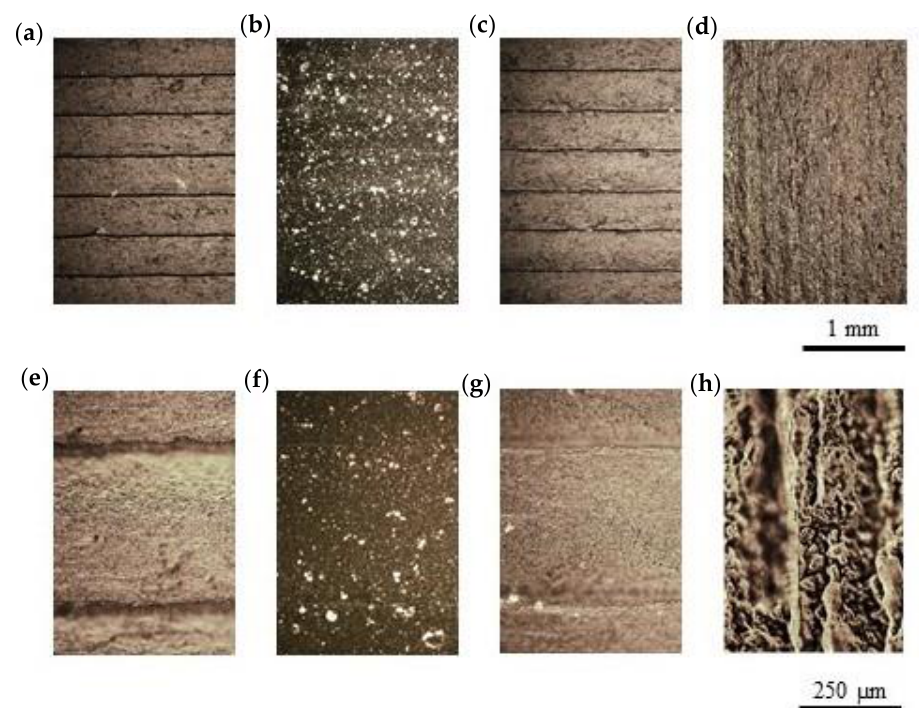
Figure 10. Optical micrographs of surface post processed parts: ( a , e ) as printed, ( b , f ) vapor polishing, ( c , g ) plasma and ( d , h ) neosanding.